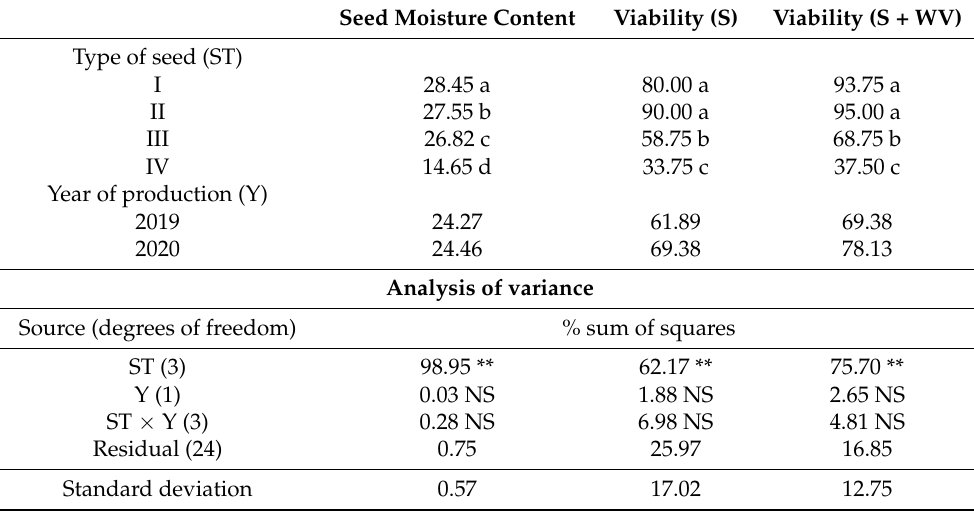
Table 3. Effects of the type of seeds and the year of their production on the seed moisture content (%) and viability (%), considering only the sound seeds (S) and both the sound and viable but with weak tissues (S + WV); mean